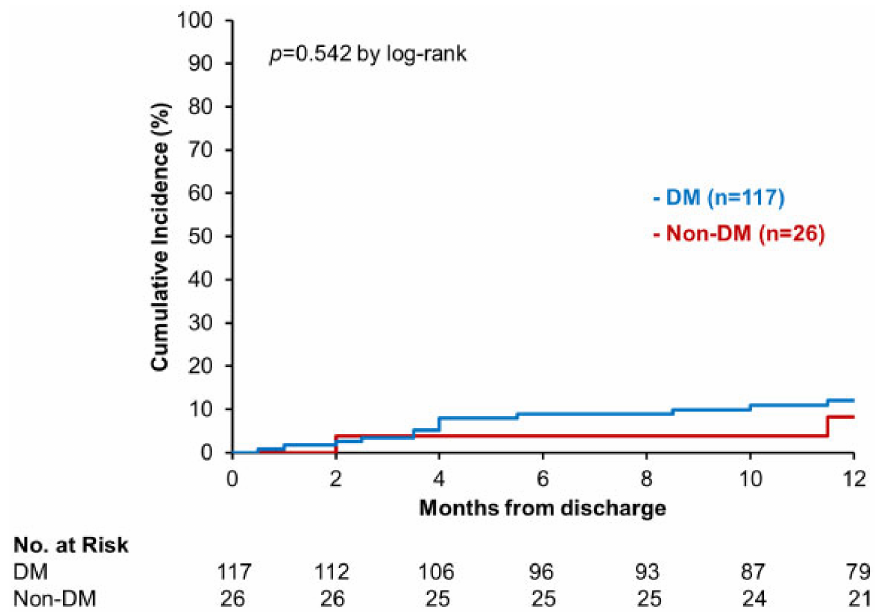
Figure 4. Recurrent hospitalization for heart failure in DM/non-DM patients.